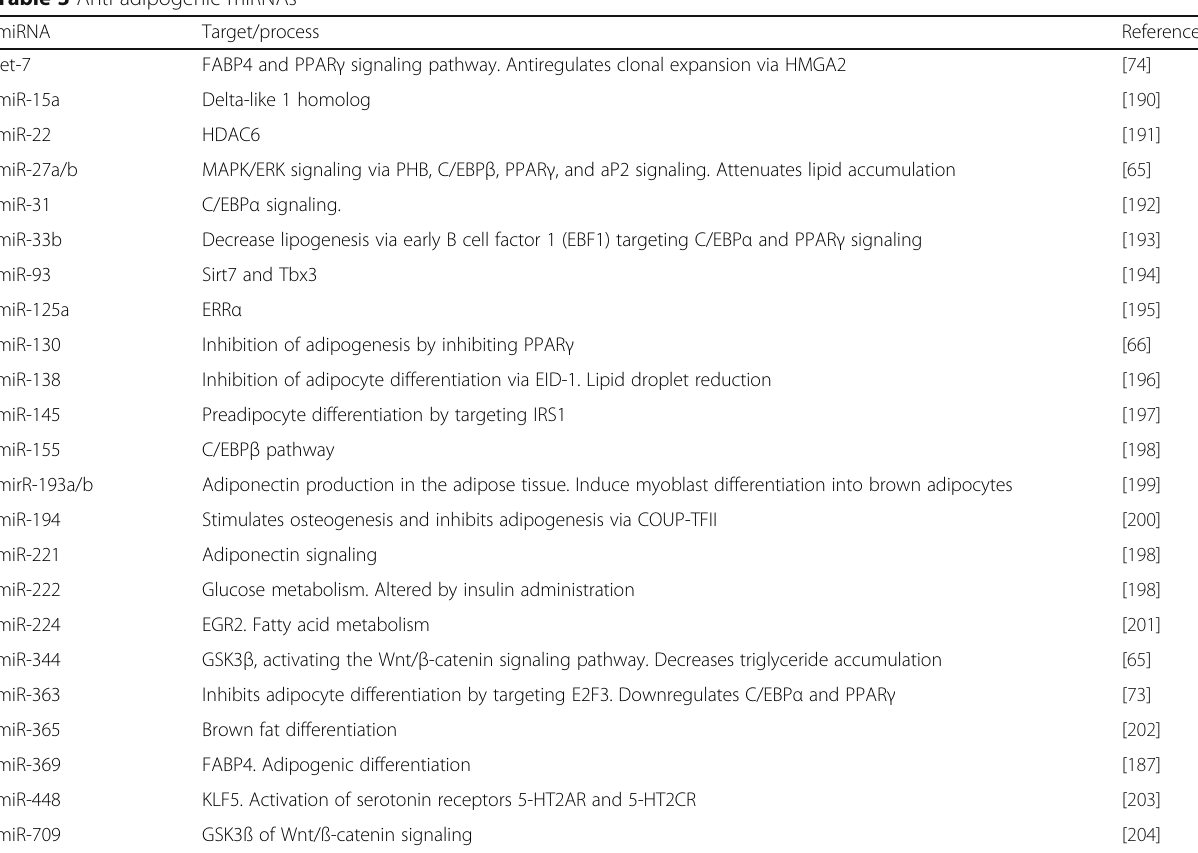
Table 3 Anti-adipogenic miRNAs